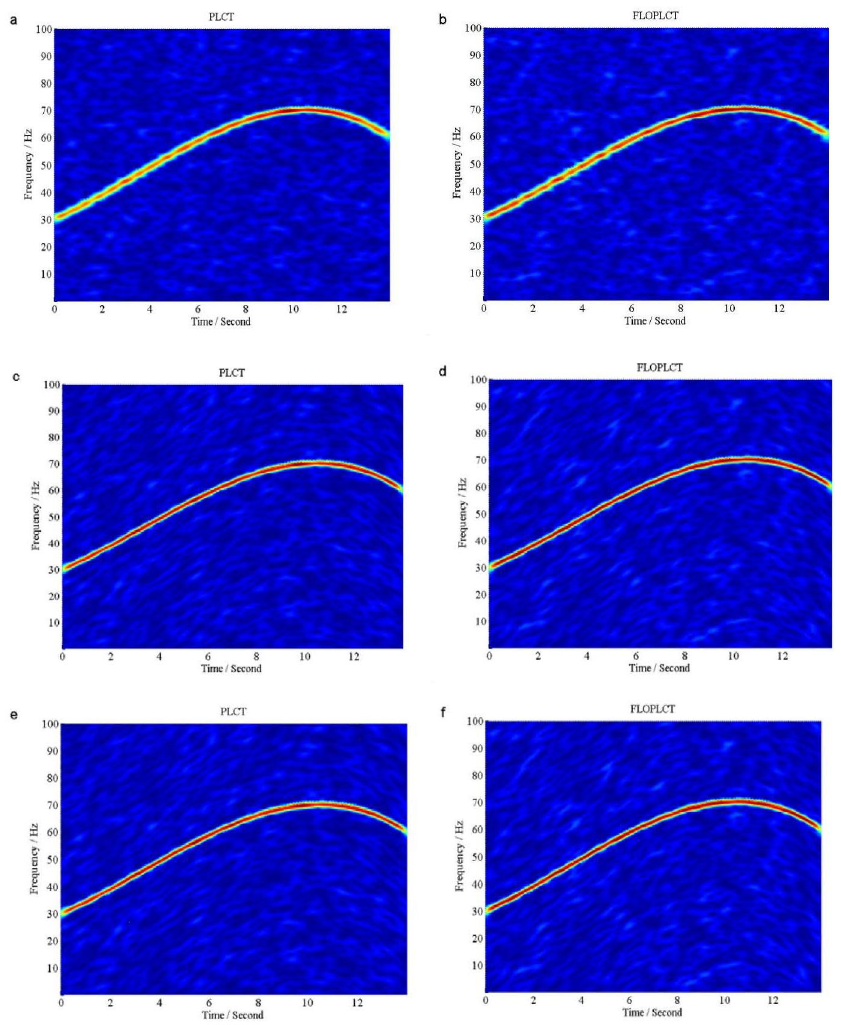
Fig 6. Time-frequency representations of the signal x ( τ ) in Gaussian noise environment ( SNR = 5 dB ). (a. The first time PLCT time-frequency representation of the signal x ( τ ); b. The first time FLOPLCT time-frequency representation of the signal x ( τ ); c. The second time PLCT time-frequency representation of the signal x ( τ ); d. The second time FLOPLCT time-frequency representation of the signal x ( τ ); e. The third time PLCT time-frequency representation of the signal x ( τ ); f. The third time FLOPLCT time-frequency representation of the signal x ( τ )).